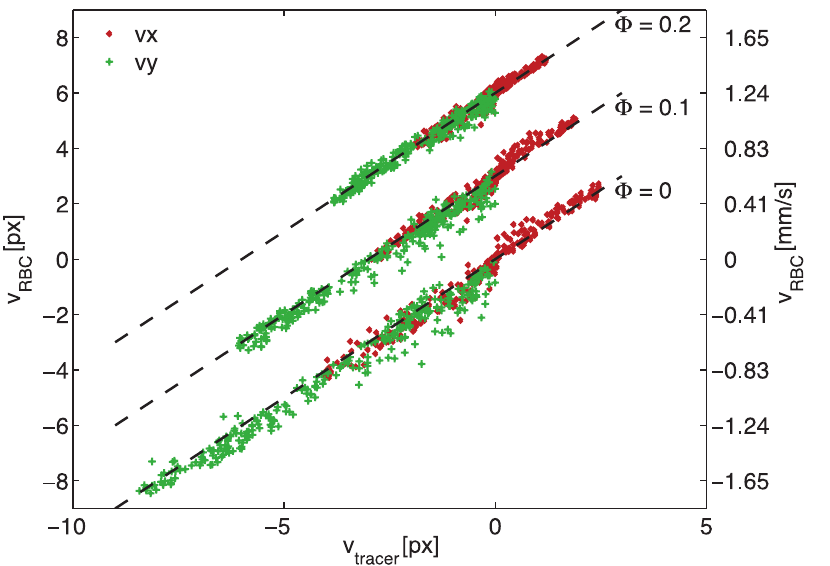
Figure 4. Agreement at M ~ 12 : 5 | . A scatterplot of the displacement measured using red blood cells versus the results using artificial tracers. Three time steps are shown, with an offset for clarity (0, 3 and 6 pixels). Horizontal and vertical components are shown separately ( : and + , respectively). The dashed lines indicate perfect agreement.